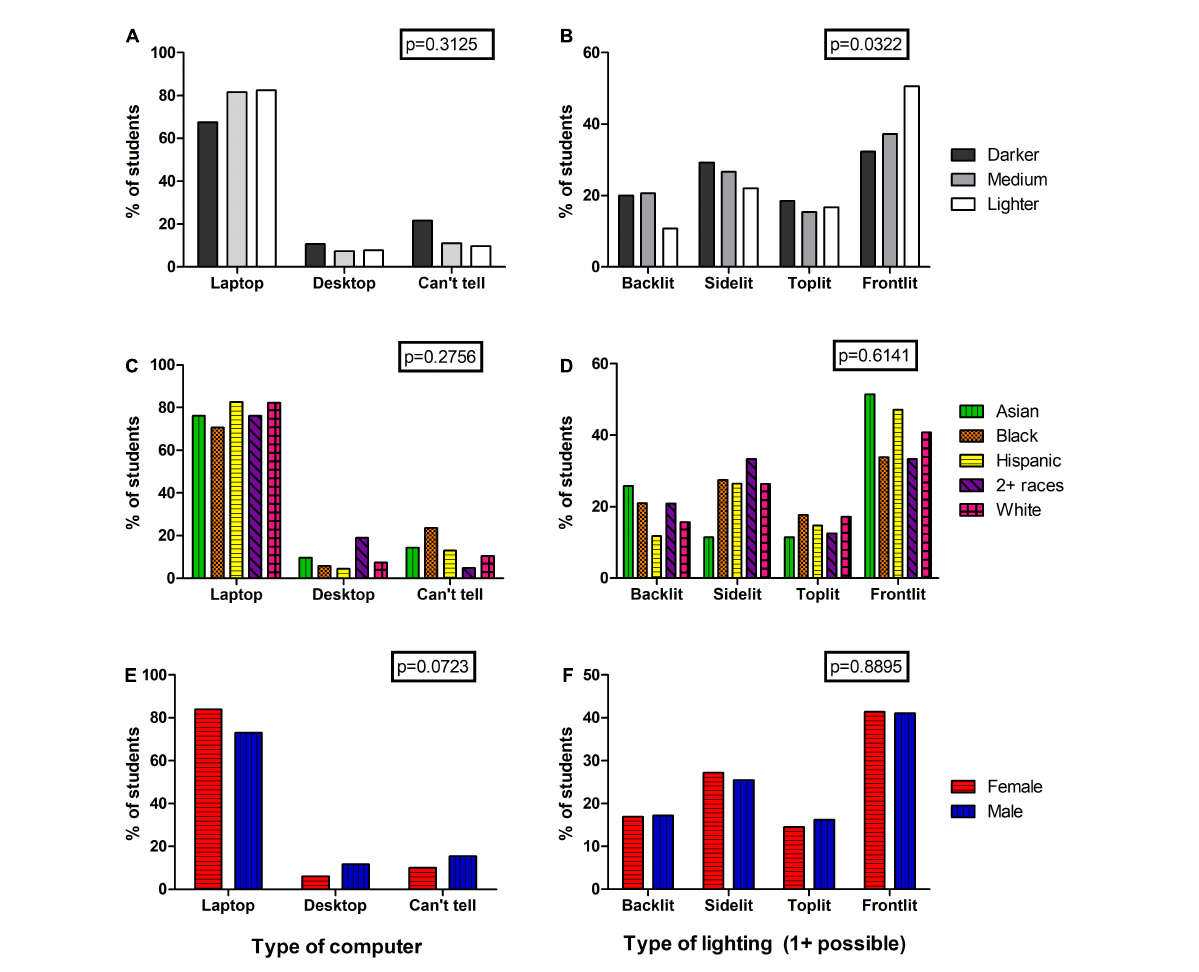
FIGURE7 Analysis of student videos for student environments. Videos of students were coded for the type of camera/computer used for the exam (A,C,E) , and what type of lighting was used for the exam (B,D,F) . For the latter, students could be lit from multiple spots (e.g., from the side and from the computer screen) and this was coded as both when applicable. Percentages are shown in each bar and are color-coded for easy comparisons. Chi-squared p -values from raw data is shown in boxes at the top of each